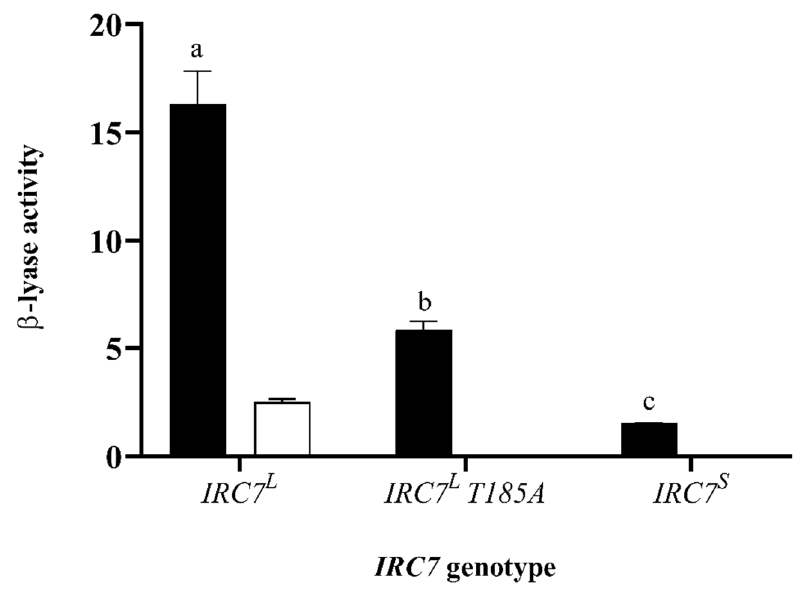
Figure 1. Enzymatic β -lyase activity towards S -(2-Thiazolyl)-L-cysteine (STC) (black) and L-cysteine (white) in cell-free protein extracts from the haploid strain AWRI1631 with chromosomal integration of different IRC7 genotypes. Each result is the mean and standard deviation of three independent replicates, and expressed as nmol min − 1 mg protein − 1 . For STC, the release of the thiol compound 2-mercaptothiazole was measured spectrophotometrically; for L-cysteine, the release of pyruvate was assessed by HPLC. No detectable activity was observed for the IRC7 L T185A and IRC7 S alleles using L-cysteine. Means with the same superscript letter are not significantly different from each other (Tukey’s test, p < 0.05).